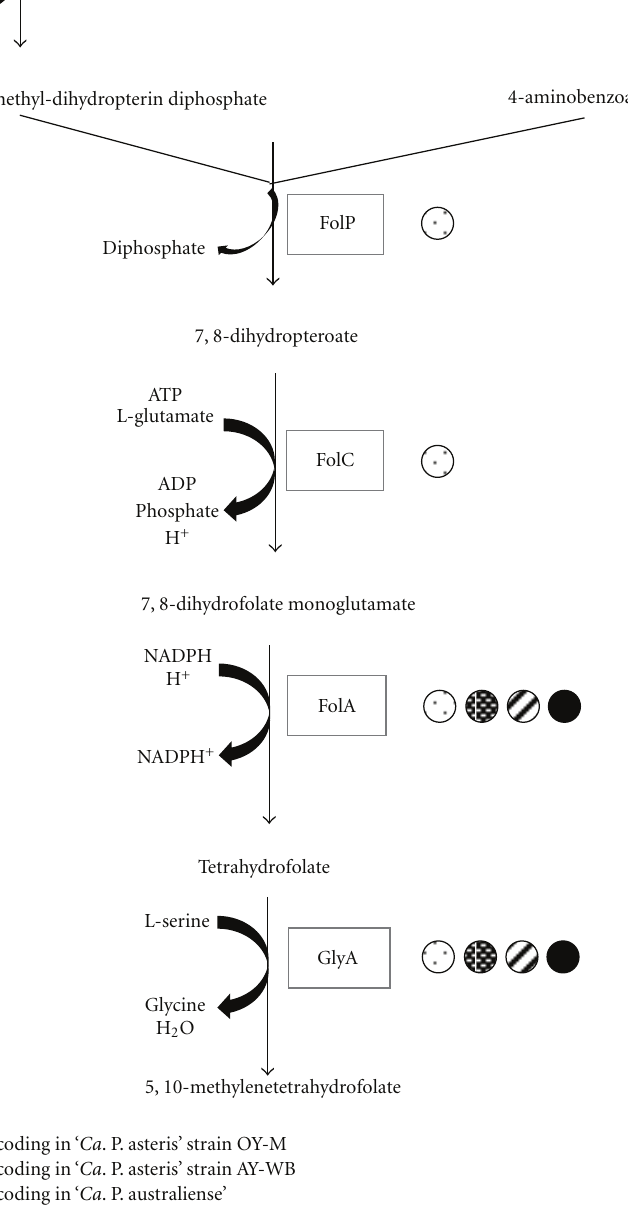
Figure 13: Folate